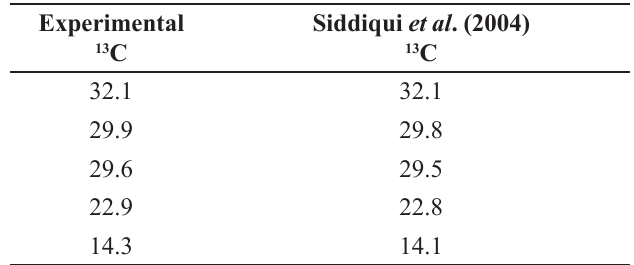
TABLE I - Compound 1 NMR (ppm) experimental data compared against literature